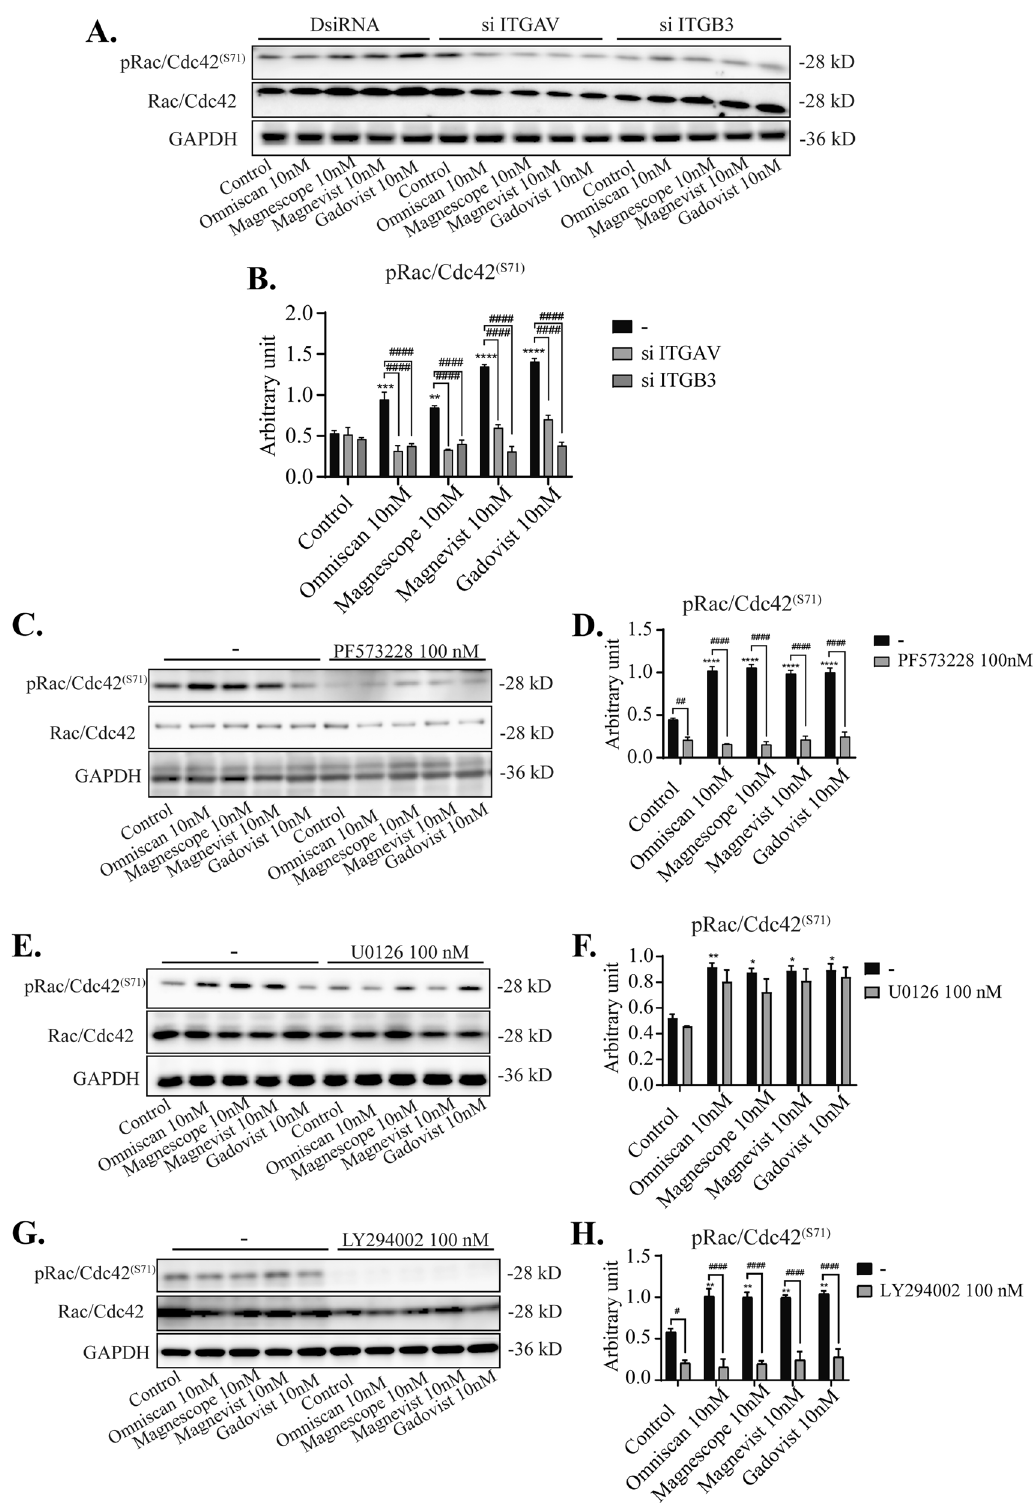
Figure 7. Effect of GBCAs on phosphorylation of RhoGTPase. The U87MG clonal cells were transfected with DsiRNA or siRNA of ITGAV and/or ITGB3, then exposed to GBCAs for 30 min after serum-starvation for 6 h. Representative blots of pRac1/Cdc42 levels of GBCAs exposure after knockdown of ITGAV or ITGB3 ( A ) or coexposure with PF573228 ( C ), U0126 ( E ), or LY294002 ( G ). Quantitative analysis of GBCAs effect on the protein expression levels of Rac1/Cdc42 (S71) after knockdown of ITGAV or ITGB3 ( B ) or coexposure with PF573228 ( D ), U0126 ( F ), or LY294002 ( H ). Full-length blots are available in supplemental information. The blots were quantified using Fiji ImageJ software (NIH). Data are expressed as the mean ± SEM of at least three independent experiments. **** p < 0.0001, *** p < 0.001, ** p < 0.01, * p < 0.05, indicates statistical significance were analysed by two-way ANOVA continued with post hoc Bonferroni’s or Turkey test compared with the control. #### p < 0.0001, # p < 0.05, indicates statistical significance were analysed by two-way ANOVA continued with post hoc Bonferroni’s or